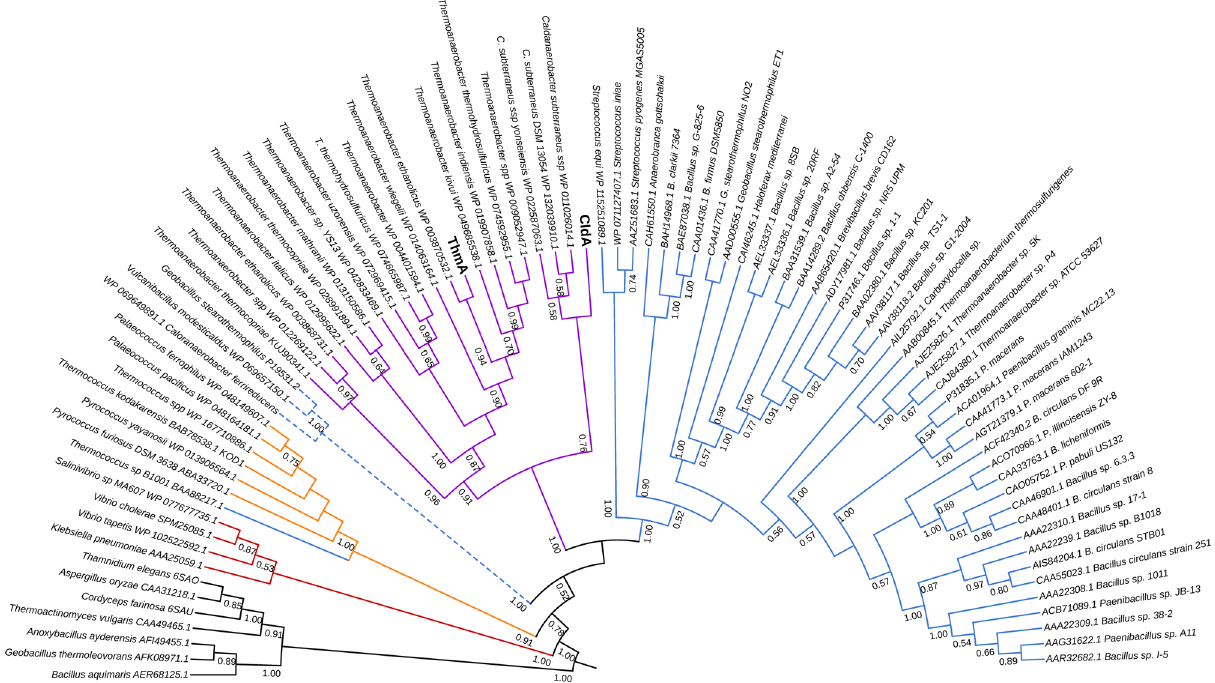
Figure 3. Phylogenetic analysis of novel three-domain ABC CGTases. Evolutionary relationships were determined by the maximum likelihood method based on the WAG + G model using the full amino acid sequences of 78 CGTases, including the 48 characterized CGTases from GH13_2 recognized in the CAZy database, 19 three-domain ABC (CldA/ThmA)-like CGTases, and 11 putative CGTases. The sequences of 7 α-amylases from GH13 were used as an outgroup. The conventional five-domain ABCDE CBM20 CGTases (blue), five-domain ABCDE arch CGTases (orange), four-domain ABCE CBM20 CGTases (red), and the novel group of 19 three-domain ABC CGTases, (CldA/ThmA)-like enzymes from thermophilic C. subterraneus ssp. and Thermoanaerobacter spp. (magenta) were observed in four different clades. The ABCDE CBM20 maltogenic starch-acting enzymes (blue dashed line) and α-amylases (black branch) from GH13_2 and GH13, respectively, are also shown in two different clades. Note that while the α-amylases from Aspergillus oryzae and Cordyceps farinosa belong to the GH13_1 subfamily, the α-amylases from bacteria showed an unassigned GH13 subfamily. Bootstrap values (1000 iterations) are indicated for each node. Only bootstrap values above 50% were shown. The tree was drawn using iTOL v4 (http:// itol. embl.